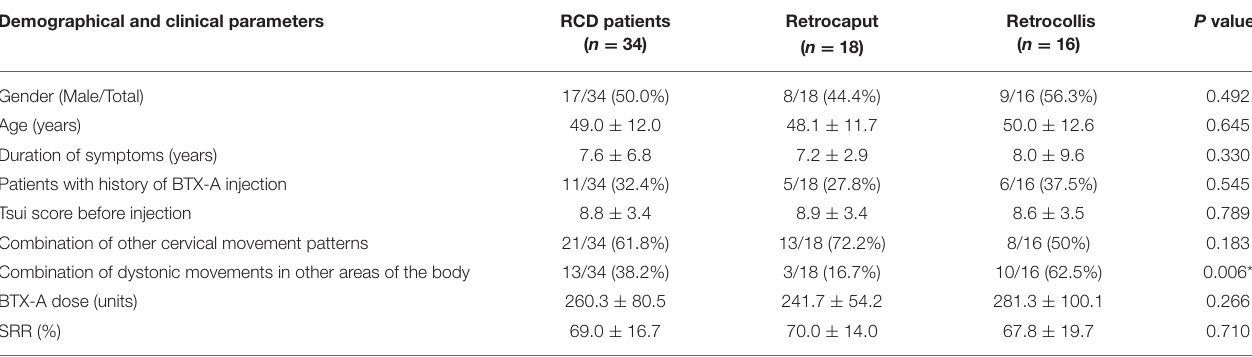
TABLE 1 | Demographical and clinical characteristics in patients with RCD. Demographical and clinical